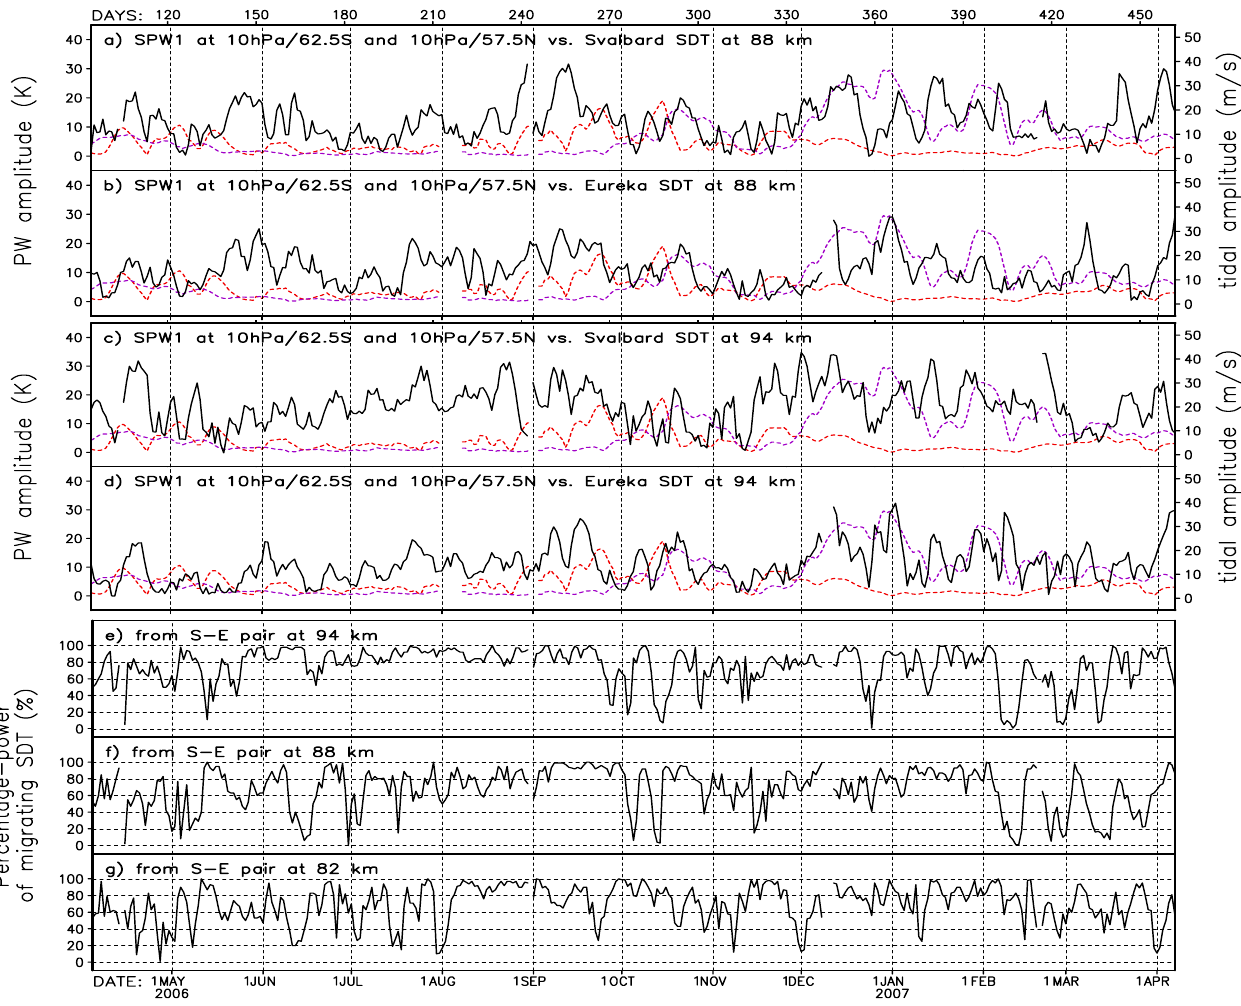
Fig. 2. Time sequences of the stationary planetary wave 1 amplitudes (dashed line; scale on left axis; shown in (a–d) at 10hPa, 60–65 ◦ S (red) and at 10hPa, 55–60 ◦ N (purple) versus the amplitudes of meridional semidiurnal tides (solid line; scale on right axis; showing in (a–d) at Svalbard (a for 88km and c for 94km) and Eureka (b for 88km and d for 94km) during 2006/2007. The percentage-power in the migrating SDT derived from the Svalbard-Eureka pair is shown in the lower sections of the figure (solid lines, e–g ).